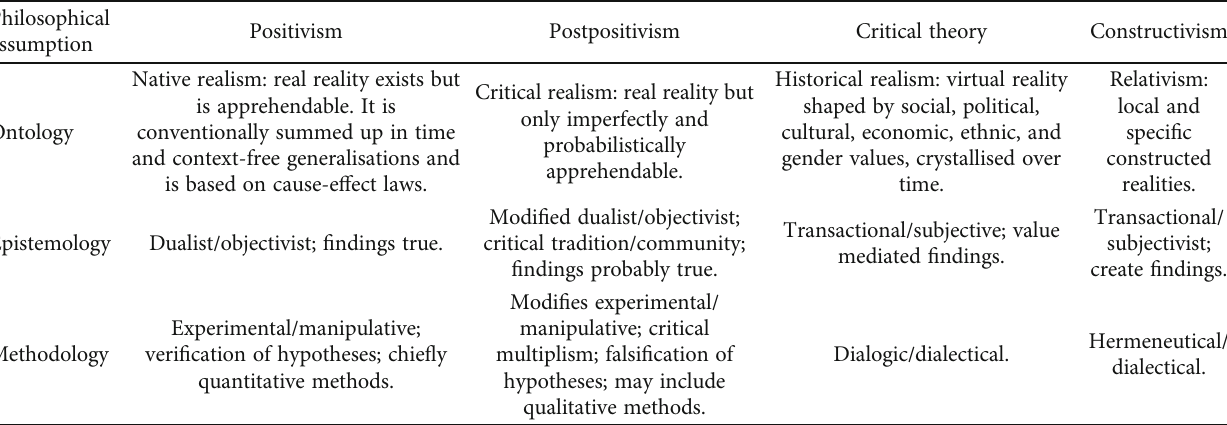
Table 3: Research paradigms.